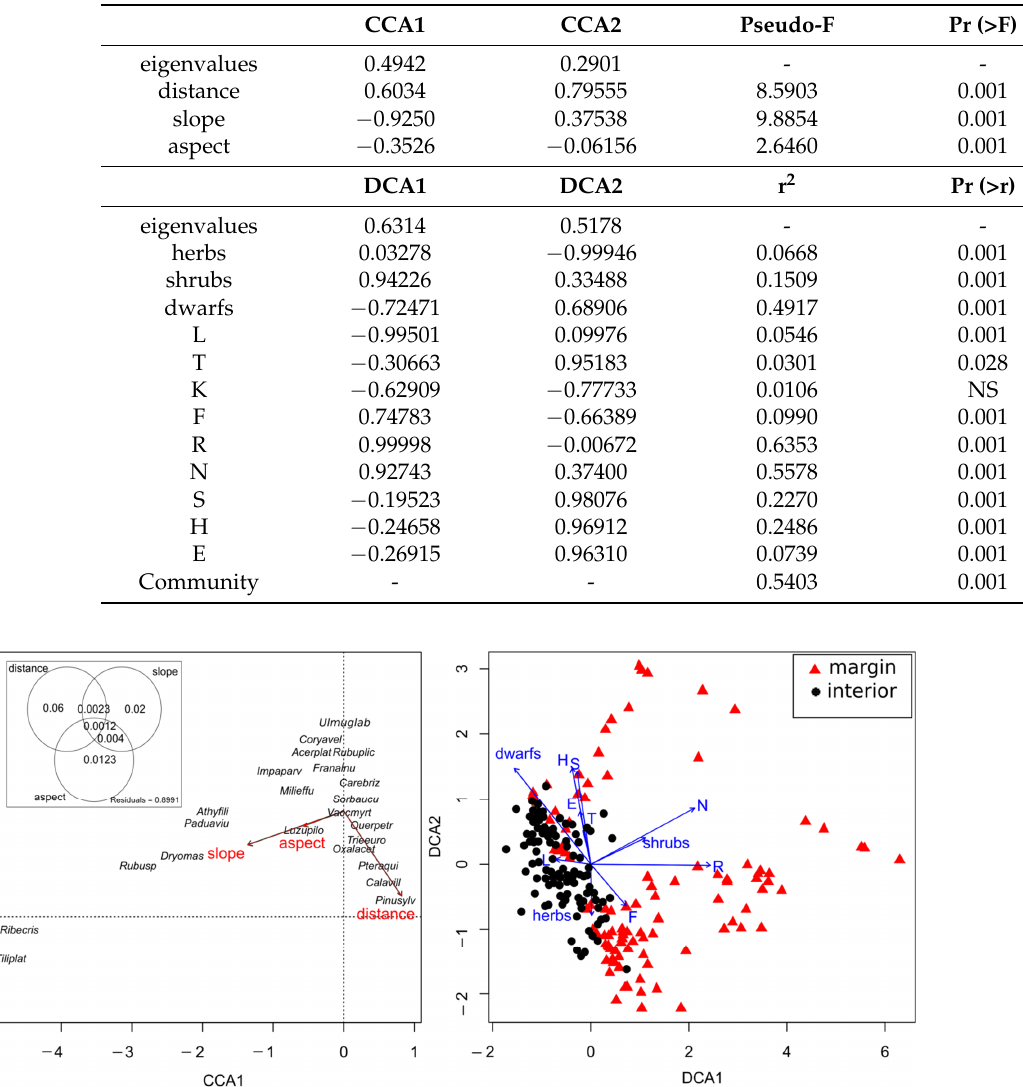
Table 4. The CCA decomposition and parameters of the explanatory variables fitted to the results of the DCA analysis.